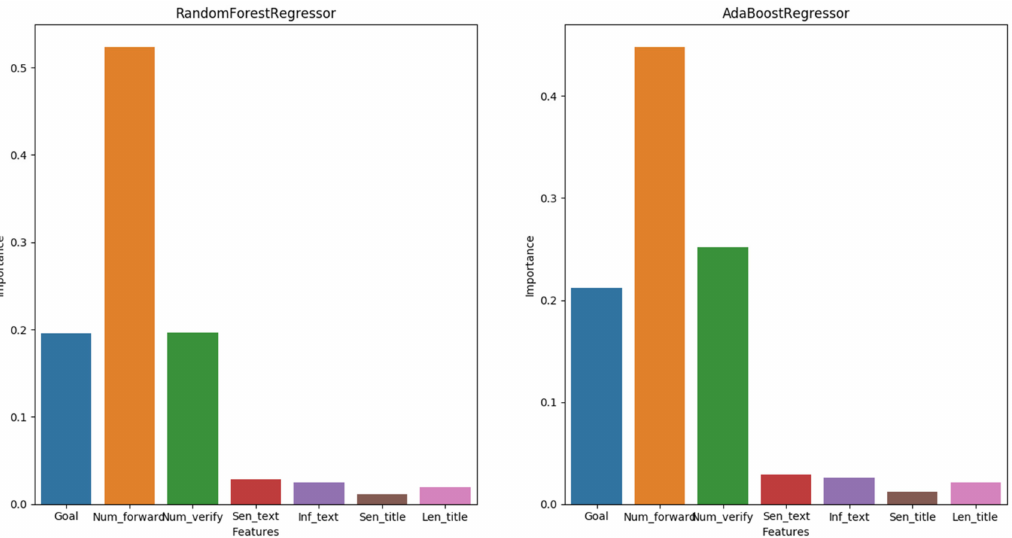
Figure 3. Arithmetic mean value of variable importance with five instances of repeated